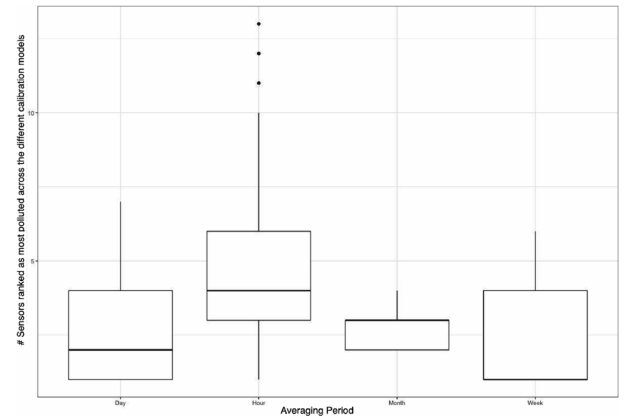
Figure 8. Variation in the number of sites that were ranked as “most polluted” across the 89 different calibration models for different time-averaging periods displayed using box